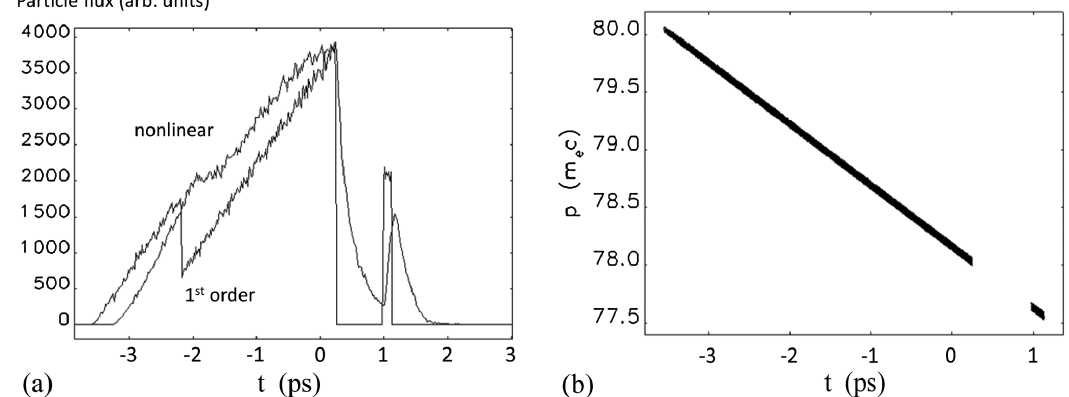
FIG. 4. The beam profile at the output of a double dogleg EEX preceded by two quadrupoles with and without accounting for the nonlinear order transfer matrix terms. The stretch (compression) factor, R 5 ; 1 , is set to R 5 ; 1 ¼ 1 . Although the output beam profile looks ideal in the first order, in reality there are strong distortions due to nonlinearities in the beam line (a). The corresponding momentum chirp of the output beam computed in first order, R 6 ; 1 ¼ − 23 m − 1 (b).